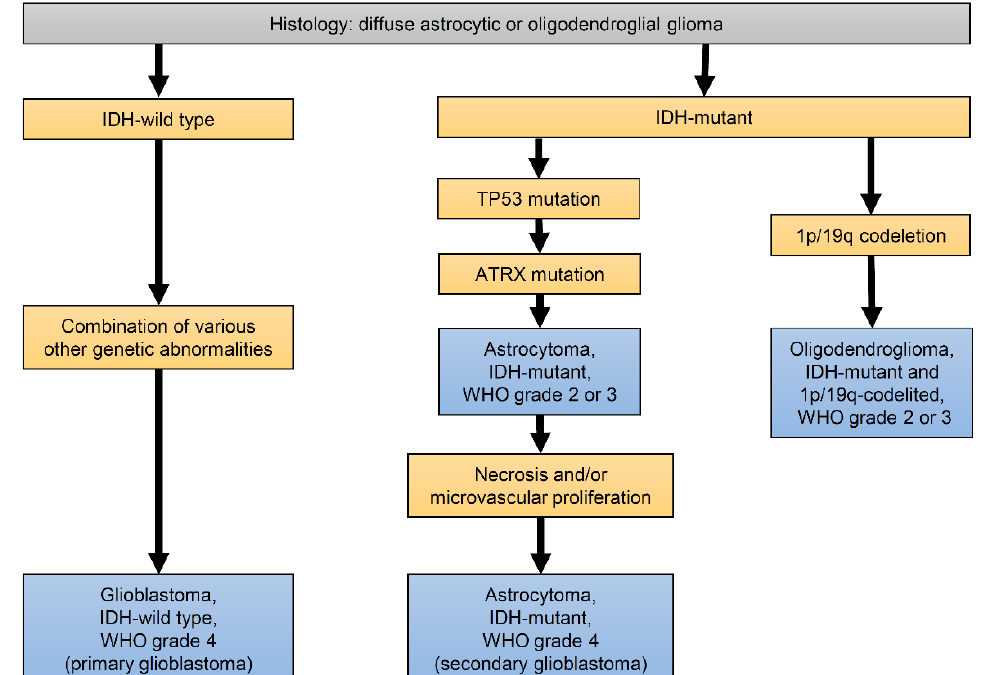
Figure 3. Diagnostic algorithm for major diffuse gliomas in adults based on the 2021 WHO Classification of Tumors of the Central Nervous System. Adult-type diffuse gliomas are thought to be caused by various genetic alterations, such as IDH mutation, 1p/19q codeletion, TP53 mutation, and ATRX mutation. IDH mutation and 1p/19q codeletion are essential in oligodendroglioma. In addition to IDH mutation, TP53 mutation and ATRX mutation occur in astrocytoma, and necrosis is associated with grade 4 astrocytoma. This is referred to as secondary glioblastoma in the 2016 WHO classification. Glioblastoma is caused by a combination of various other genetic abnormalities without IDH mutation.